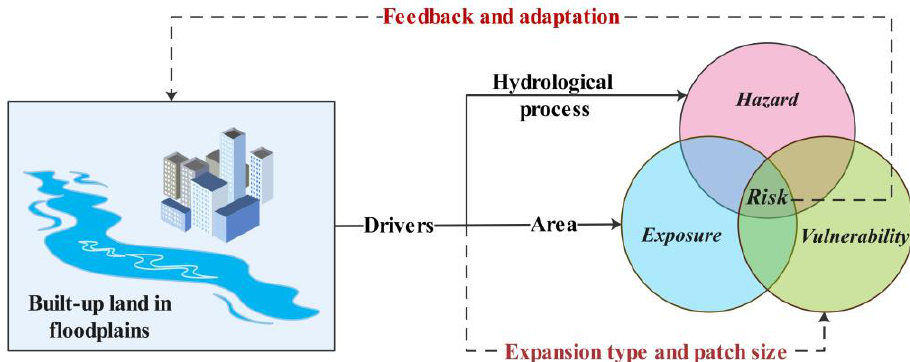
Figure 1. Schematic of the interplay between the built-up land in floodplains and the flood risk system from a socio-hydrology perspective.